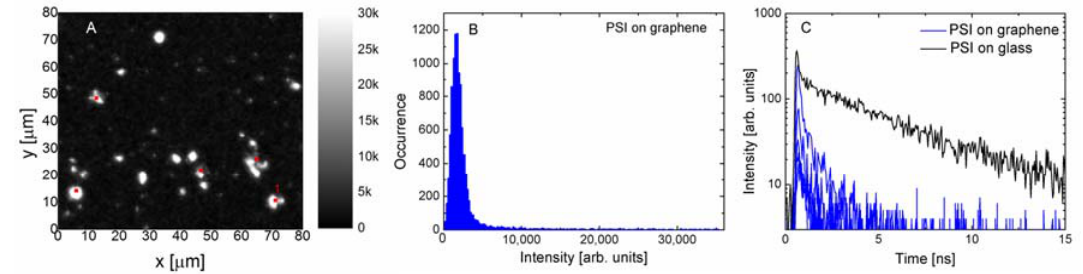
Figure 3. ( A ) Fluorescence intensity map measured for PSI complexes deposited on a monolayer graphene using the excitation wavelength of 485 nm. ( B ) Histogram of fluorescence intensity extracted from the map. ( C ) Fluorescence intensity decays measured for PSI complexes on monolayer graphene (blue lines) for the spots indicated in ( A ) compared with the reference transient (black line).